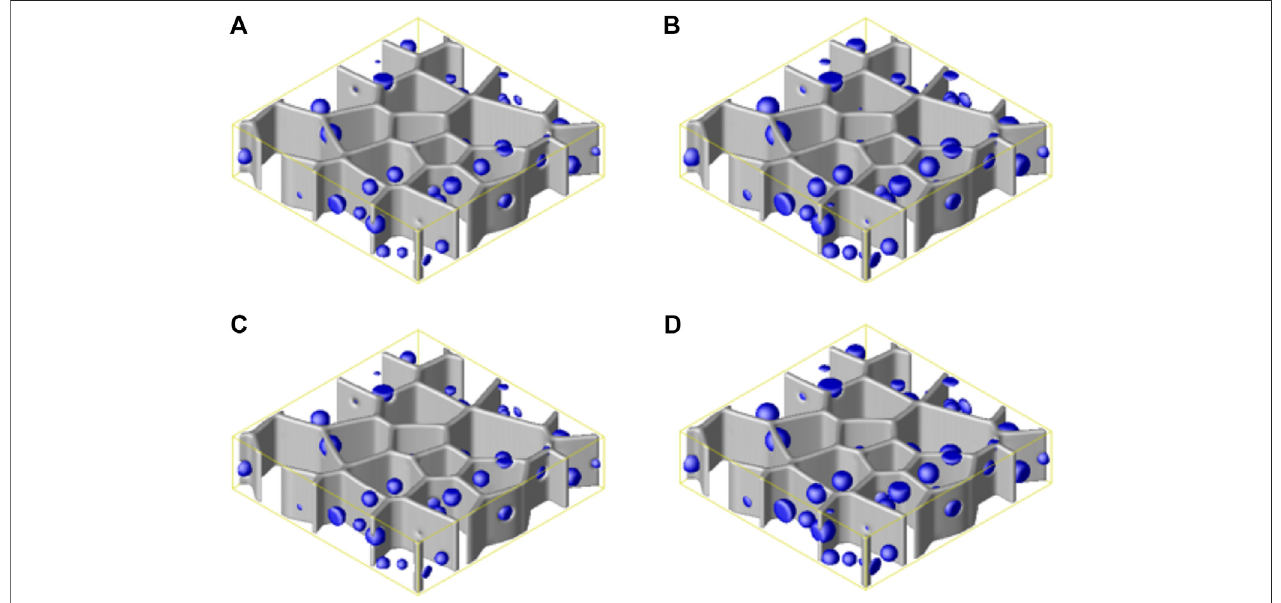
FIGURE 8 | Gas bubble structures at time t (cid:2) 240h. (A) Xe rich ε 0 (cid:2) 0 . 1 under compressive stress state ε 33 (cid:2) − 0 . 05, (B) Xe rich ε 0 (cid:2) 0 . 1 under tensile stress state ε